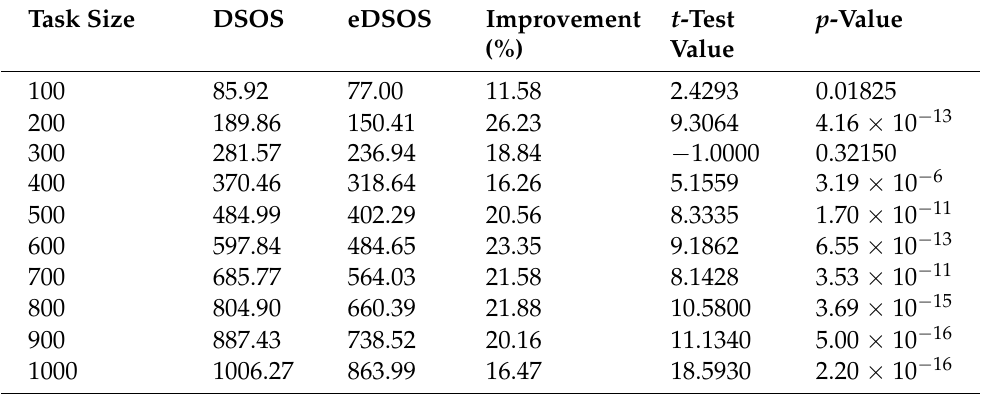
Table 7. Comparison of the makespans of DSOS and eDSOS for the dataset with the right-half distribution.